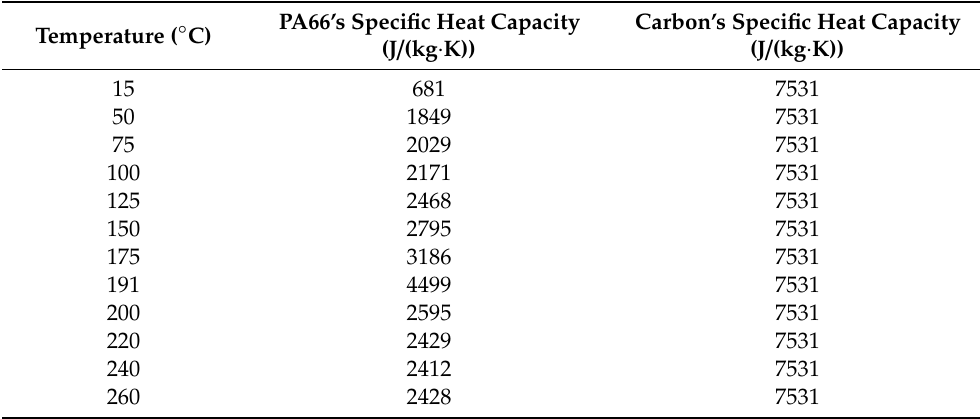
Table 2. Specific heat at di ff erent temperatures of PA66 and carbon